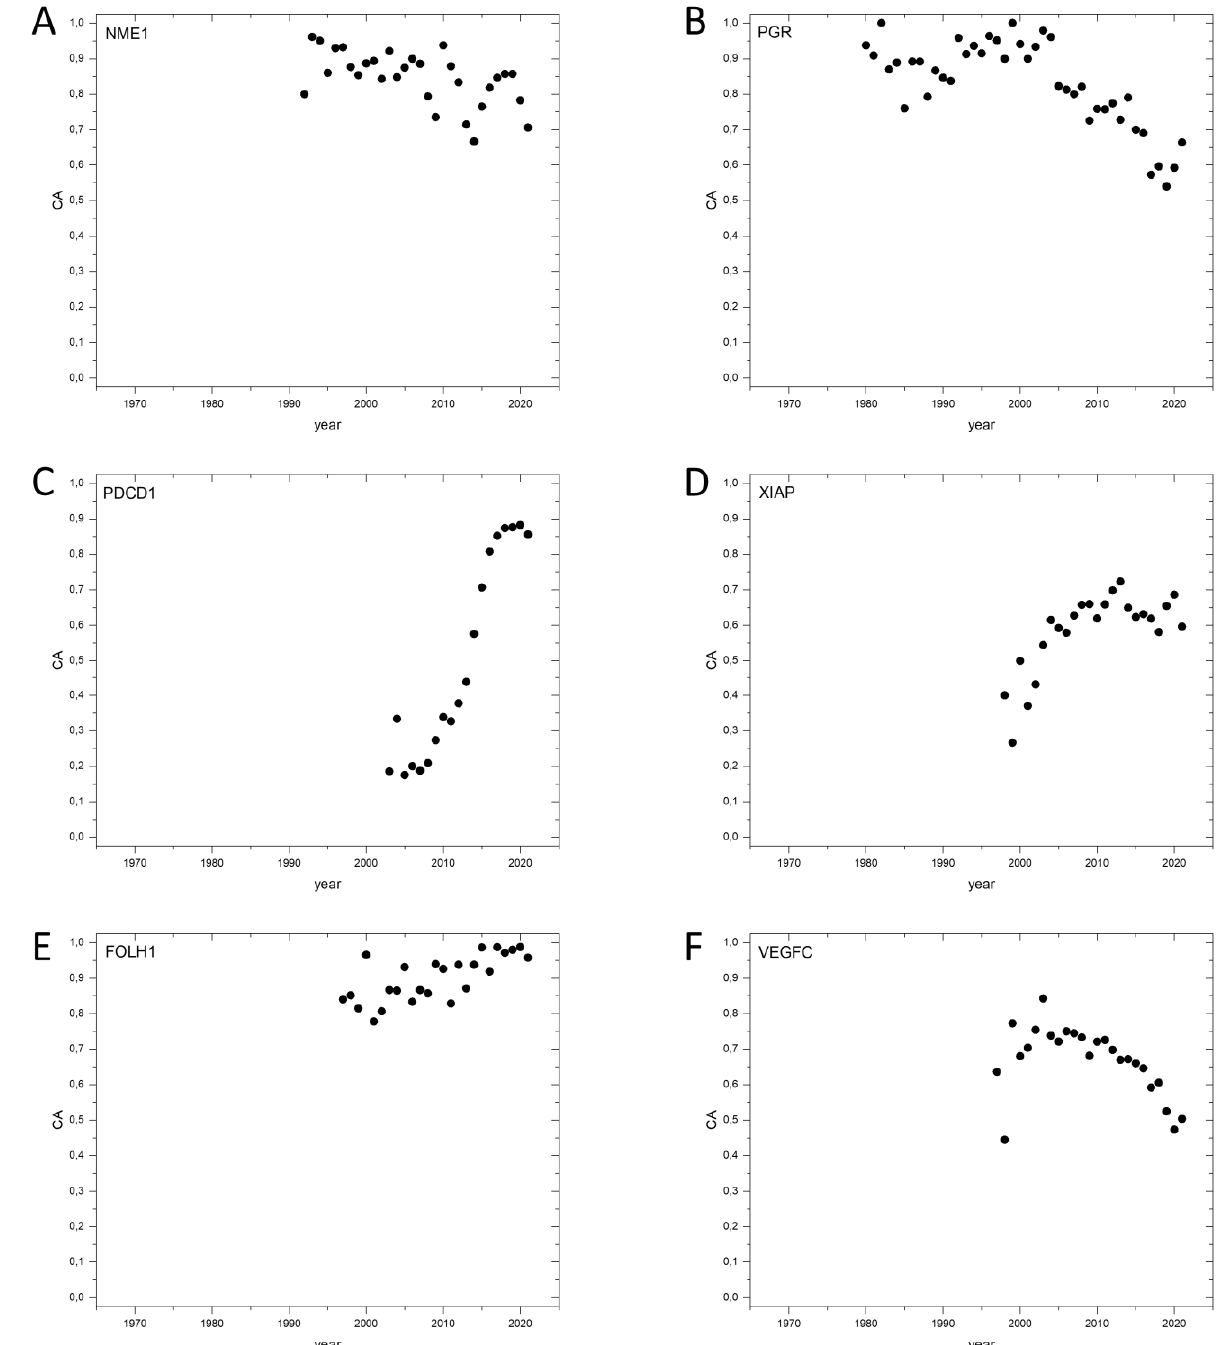
Figure 6. Dynamics of CA (Cancer_Pubs/All_Pubs) parameters of selected genes with high CA t values but missing from the lists of known cancer genes. ( A ): NME1 , Nucleoside diphosphate kinase A. ( B ): PGR , Progesterone receptor. ( C ): PDCD1 , Programmed cell death protein 1. ( D ): XIAP , E3 ubiquitin-protein ligase XIAP. ( E ): FOLH1, Glutamate carboxypeptidase 2. ( F ): VEGFC , Vascular endothelial growth factor